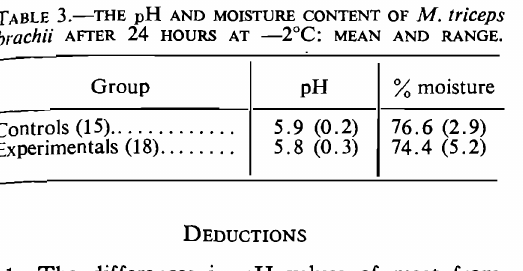
TABLE 3.-THE pH AND MOISTURE CONTENT OF M. triceps hrachii AFTER 24 HOURS AT _2°C: MEAN AND RANGE.